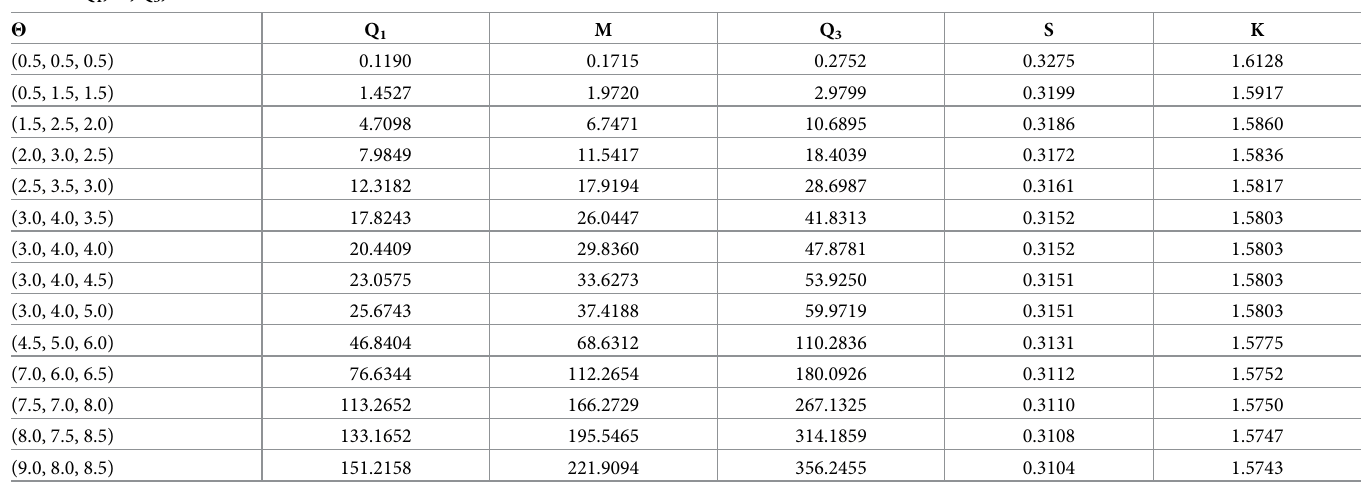
Table 1. Q 1 , M , Q 3 , S and K for